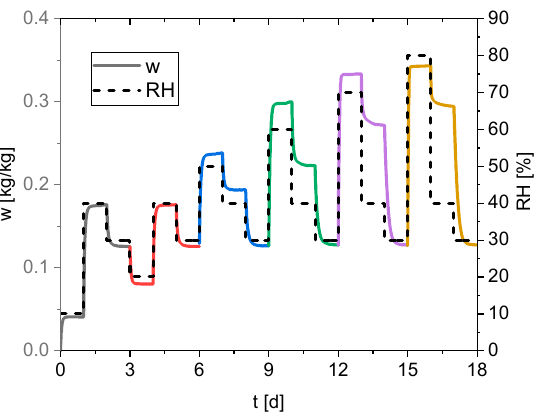
Figure 2. Measured water content of the silica gel (continuous line) and the set relative humidity profile (dashed line).